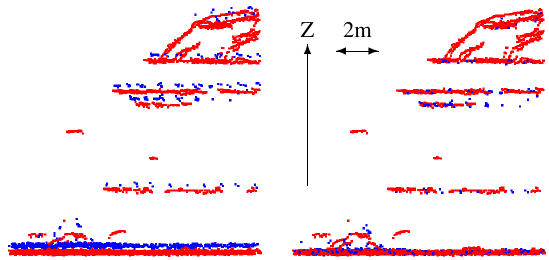
Figure 8: Illustration of the registration procedure for the ALS dataset ( default configuration, one color per strip, focus on a building corner, profile view). Left: before registration. Right: after registration.